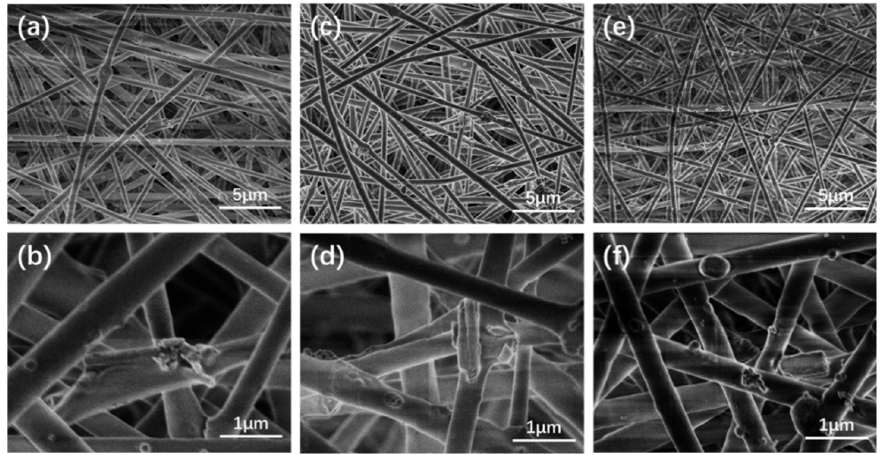
Figure 4. SEM images of ( a , b ) PSCP5-NF, ( c , d ) PSCP10-NF and ( e , f ) PSCP15-NF; TEM images of PSCP5-NF.